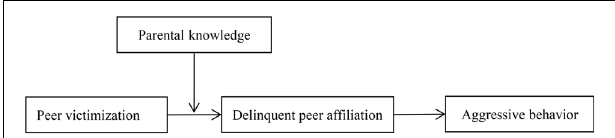
FIGURE 1 | The proposed moderated mediation